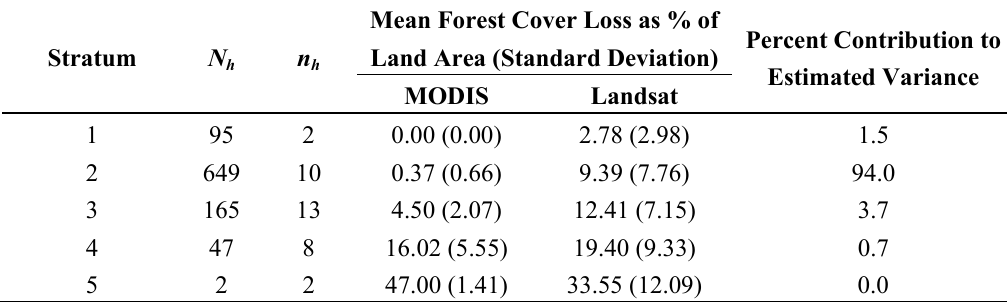
Table 3. Gross forest cover loss by stratum for Malaysia